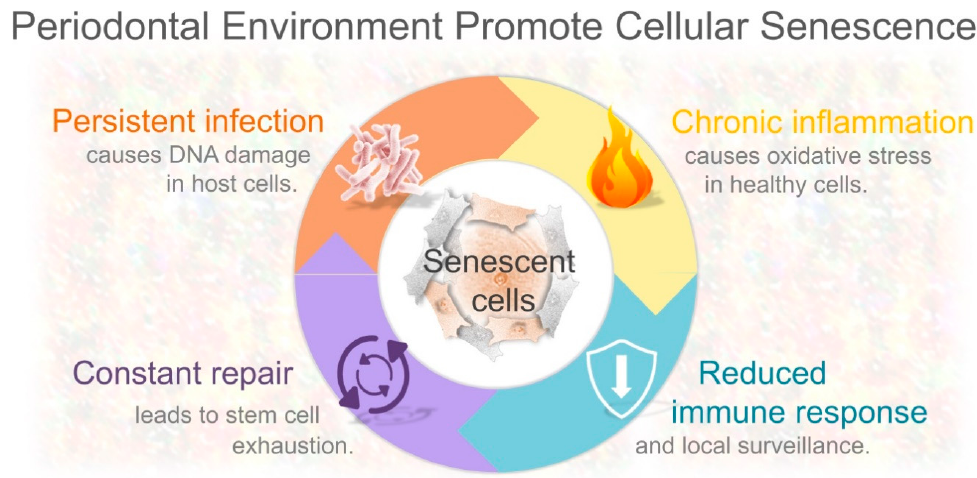
Figure 2. Interconnected factors that may contribute to the accumulation of senescent cells in periodontal microenvironment. Persistent Gram-negative bacterial infection causes chronic inflammation and DNA damage in host cells. Chronic inflammation itself induces oxidative stress in healthy cells. Downregulated local immune response and immune surveillance. Constant renewal of damaged periodontal tissues leads to stem cell